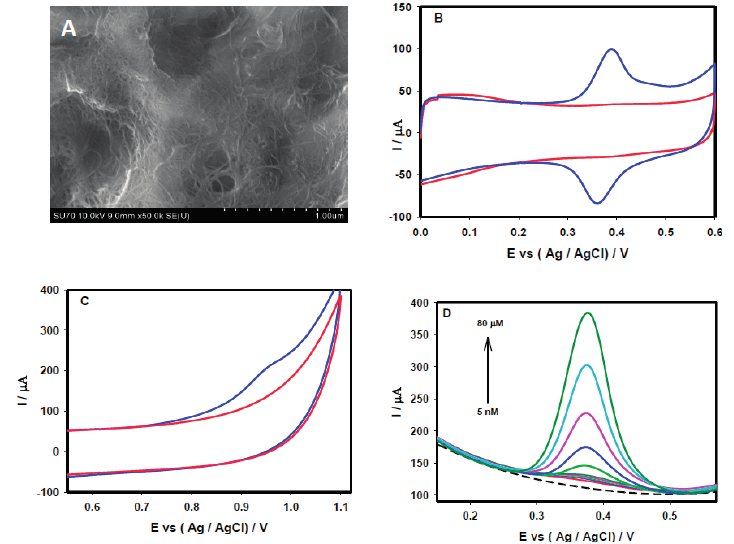
Figure 6. ( A ) FE-SEM images of the SWCNTs-rGO nanocomposite on the GCE surface. CV performance recorded at the SWCNT-rGO nanocomposite/GCE in the absence (red solid line), and presence of (blue solid line) ( B ) 50 µM acetaminophen, ( C ) 50 µM valacyclovir in 0.1 M PBS (pH 7.4) at a scan rate of 20 mV/s. ( D ) DPVs of the SWCNT- rGO nanocompoposite/GCE recorded in 0.1 M PBS (pH 7.4) containing different acetaminophen concentrations (5 nM to 80